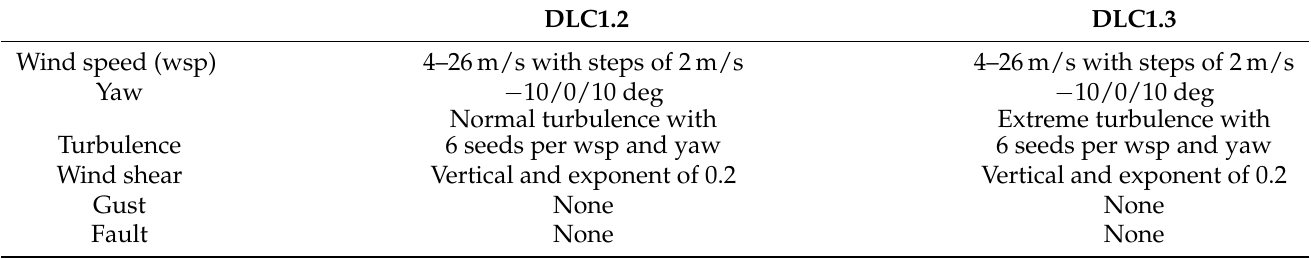
Table 5. General inputs for load cases. There are, in total, 216 simulation cases for each DLC. DLC1.2